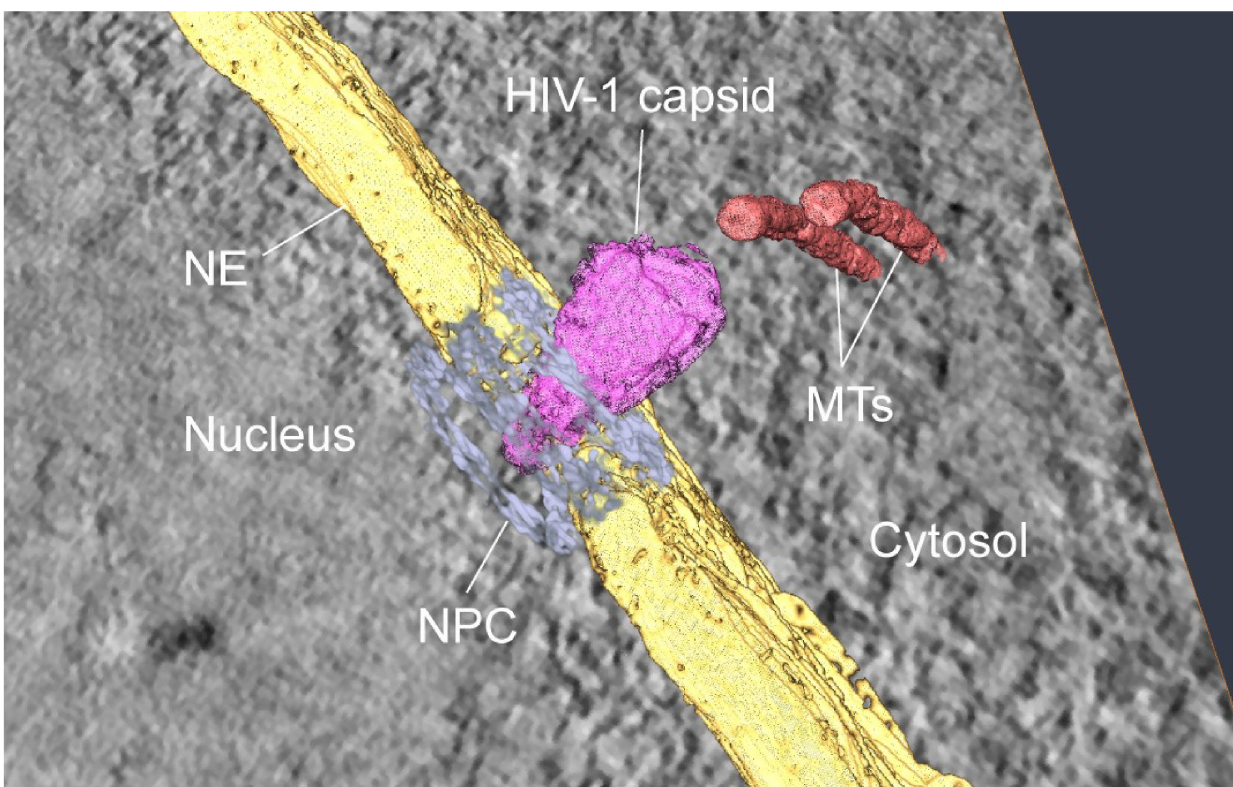
Fig 2. Nuclear import of HIV-1 CA visualized by ET. Three-dimensional rendering of electron tomographic reconstruction shows the HIV-1 capsid penetrating the NPC central channel in an infected T lymphoblast. ET, electron tomography; HIV-1, human immunodeficiency virus (1); NE, nuclear envelope; NPC, nuclear pore complex; MT, microtubule. Adapted from Lucic and colleagues [31] .